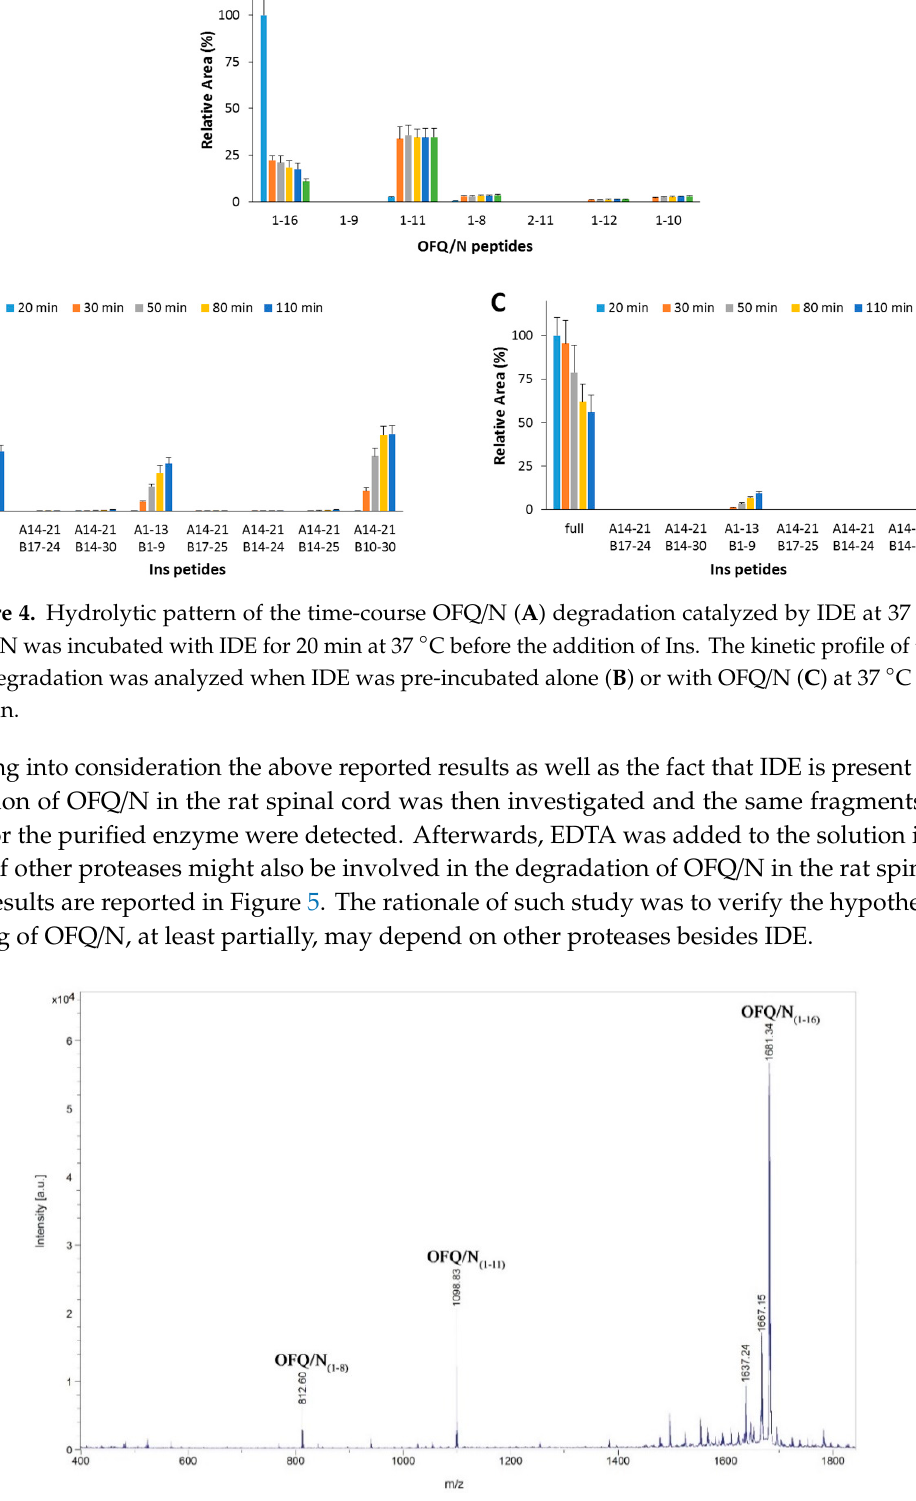
Figure 5. Identification by MALDI-MS of the major products after incubation of the neuropeptide OFQ/N with the homogenate obtained from the rat spinal cord. The incubation was performed using one microliter of the whole homogenate diluted with 19 µL of 20 mM Tris-HCl, 1 mM EDTA, pH 7.8, and 10 µL of Milli-Q water. The peptide concentration was 0.5 µg/mL, the incubation time was 30 min at 37 °C.